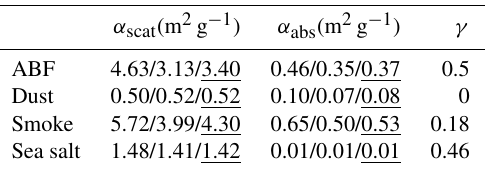
Table 2. Optical properties for the four aerosol types considered in NAAPS-RA at three wavelengths (450/550/532nm). NAAPS-RA optical properties are defined at 450 and 550nm, and these were used to interpolate values for 532nm, which are underlined below. Optical properties are based on the software package OPAC (Op- tical Properties of Aerosols and Clouds; Hess et al., 1998) at vari- ous wavelengths for ABF species, dust, and sea salt. Smoke optical properties are based on Reid et al. (2005). “ABF” stands for anthro- pogenic and biogenic fine